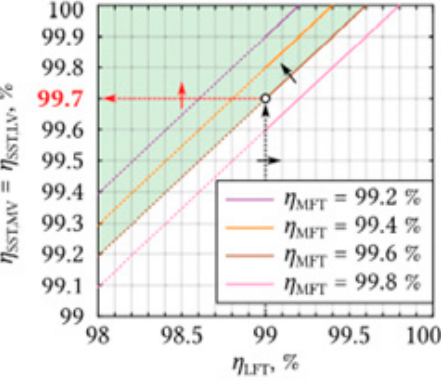
Figure 13. Diagrams of a standard SST: ( a ) low-frequency distribution transformer with a delta-wye connection (LFT), ( b ) SST.